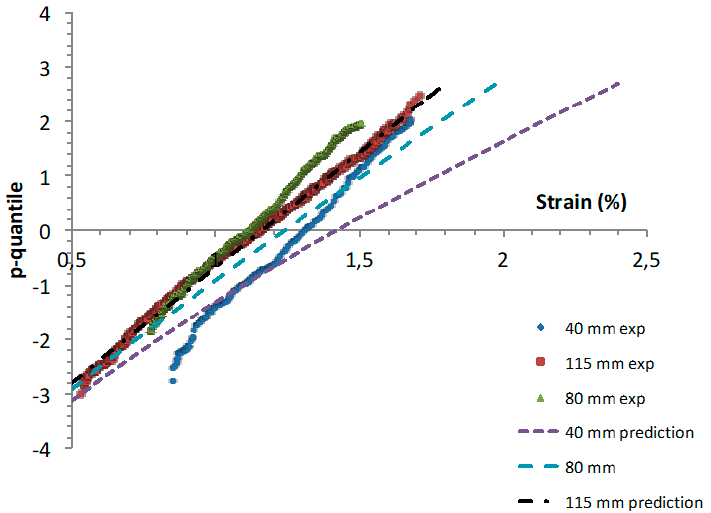
Figure 7. Comparison of experimental p-quantile diagrams with predictions from the 115 mm gauge length p-quantile diagram (as baseline).